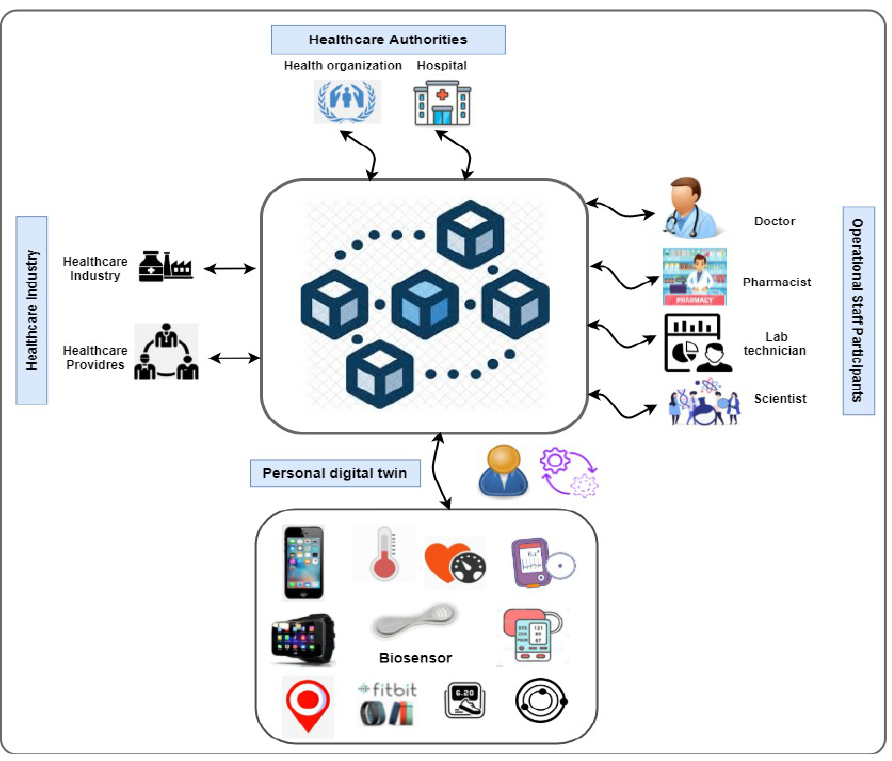
Figure 10. The participants of the blockchain network include personal digital twins, healthcare authorities, healthcare industry, and operational staff